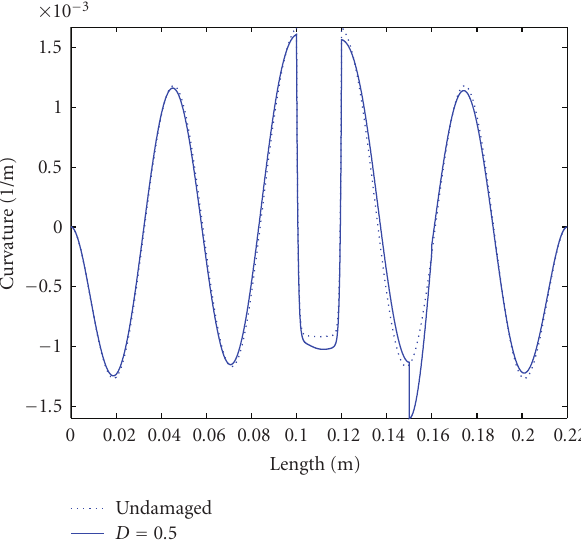
Figure 7: Curvature mode shapes along the length of the beam ( D = 0 .